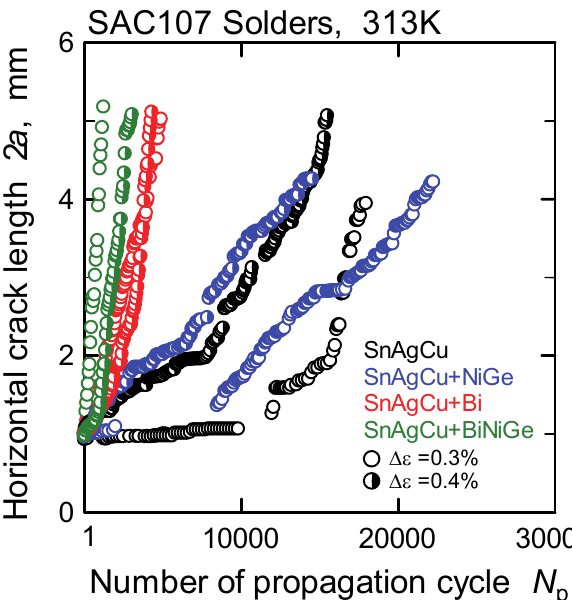
Figure 7: Crack propagation curve of Sn-low-Ag-Cu solders at 313